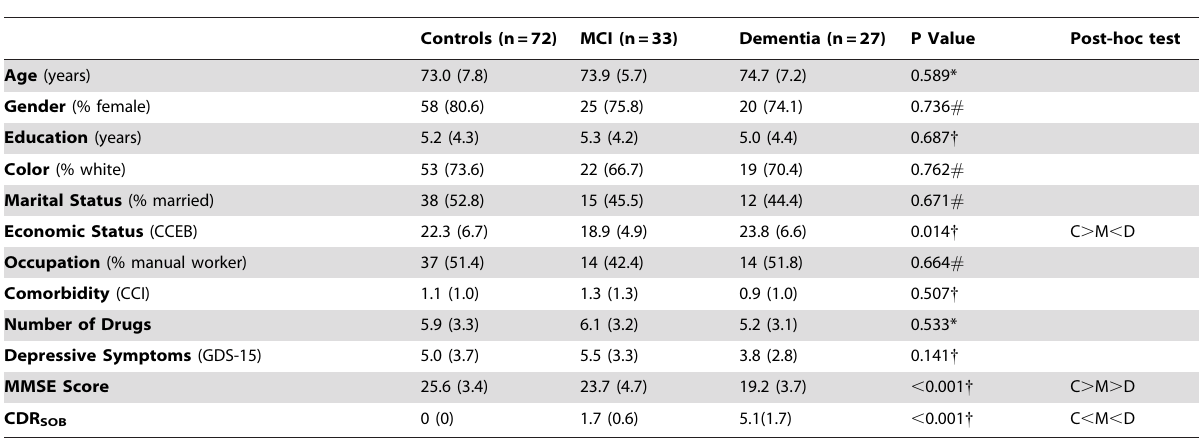
Table 2. Demographic and clinical characteristics of the study participants.